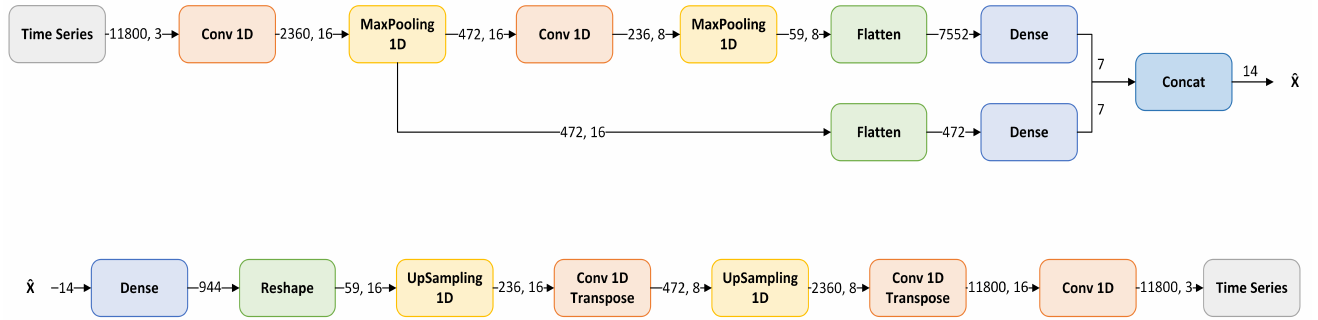
Figure 2. The structure of the autoencoder used to compress the cycles. The skip link allows us to retain both local and global